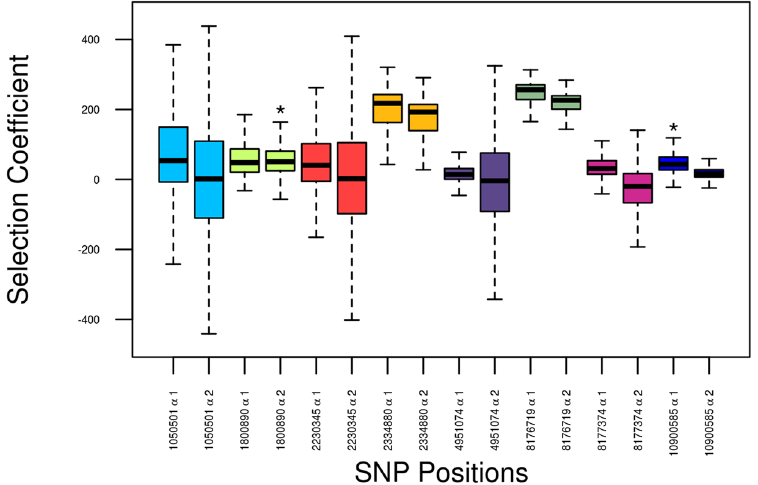
Figure 3. Mean values and standard deviations of the alpha 1 and alpha 2 selection coefficients for the malaria- resistant SNPs that exhibit variability (https://github.com/Schraiber/selection). * Statistically significant selection